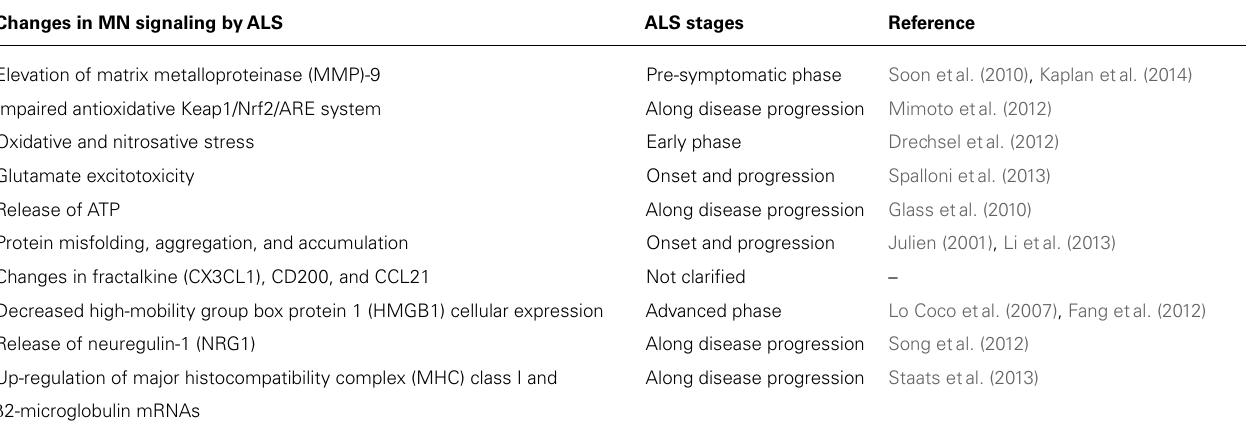
Table 1 | Functional alterations of motor neurons (MNs) in amyotrophic lateral sclerosis (ALS): candidate molecular